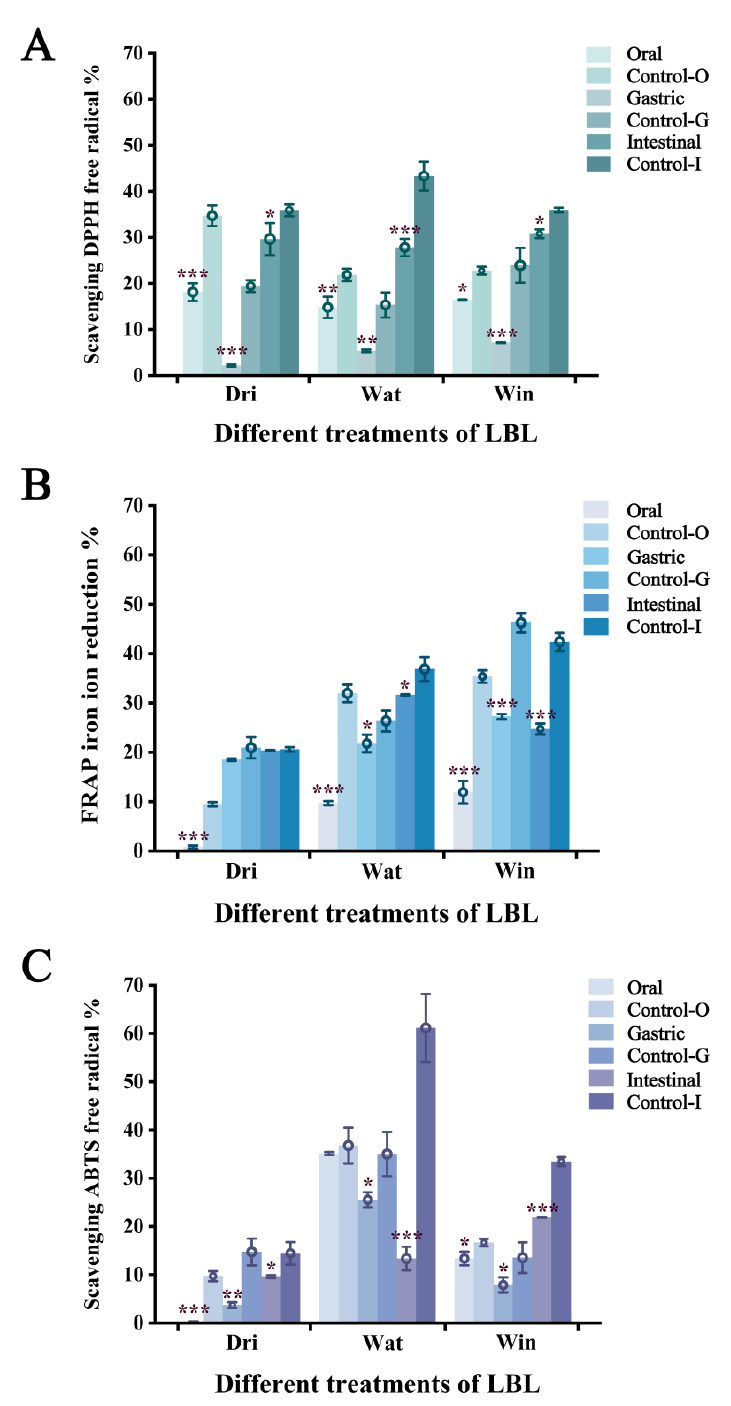
Figure 4. DPPH free radical scavenging capacity ( A ); FRAP iron ion reduction free radical capacity ( B ); and ABTS scavenging capacity ( C ) of LBL in different treatments. The control groups are LBL without corn oil addition in the oral, gastric and intestinal digestive stage (Control − O, Control − G, Control − I). “*” indicates a significant difference between the treatment and control groups ( p < 0.05), “**” indicates p < 0.01, and “***” indicates p < 0.001.